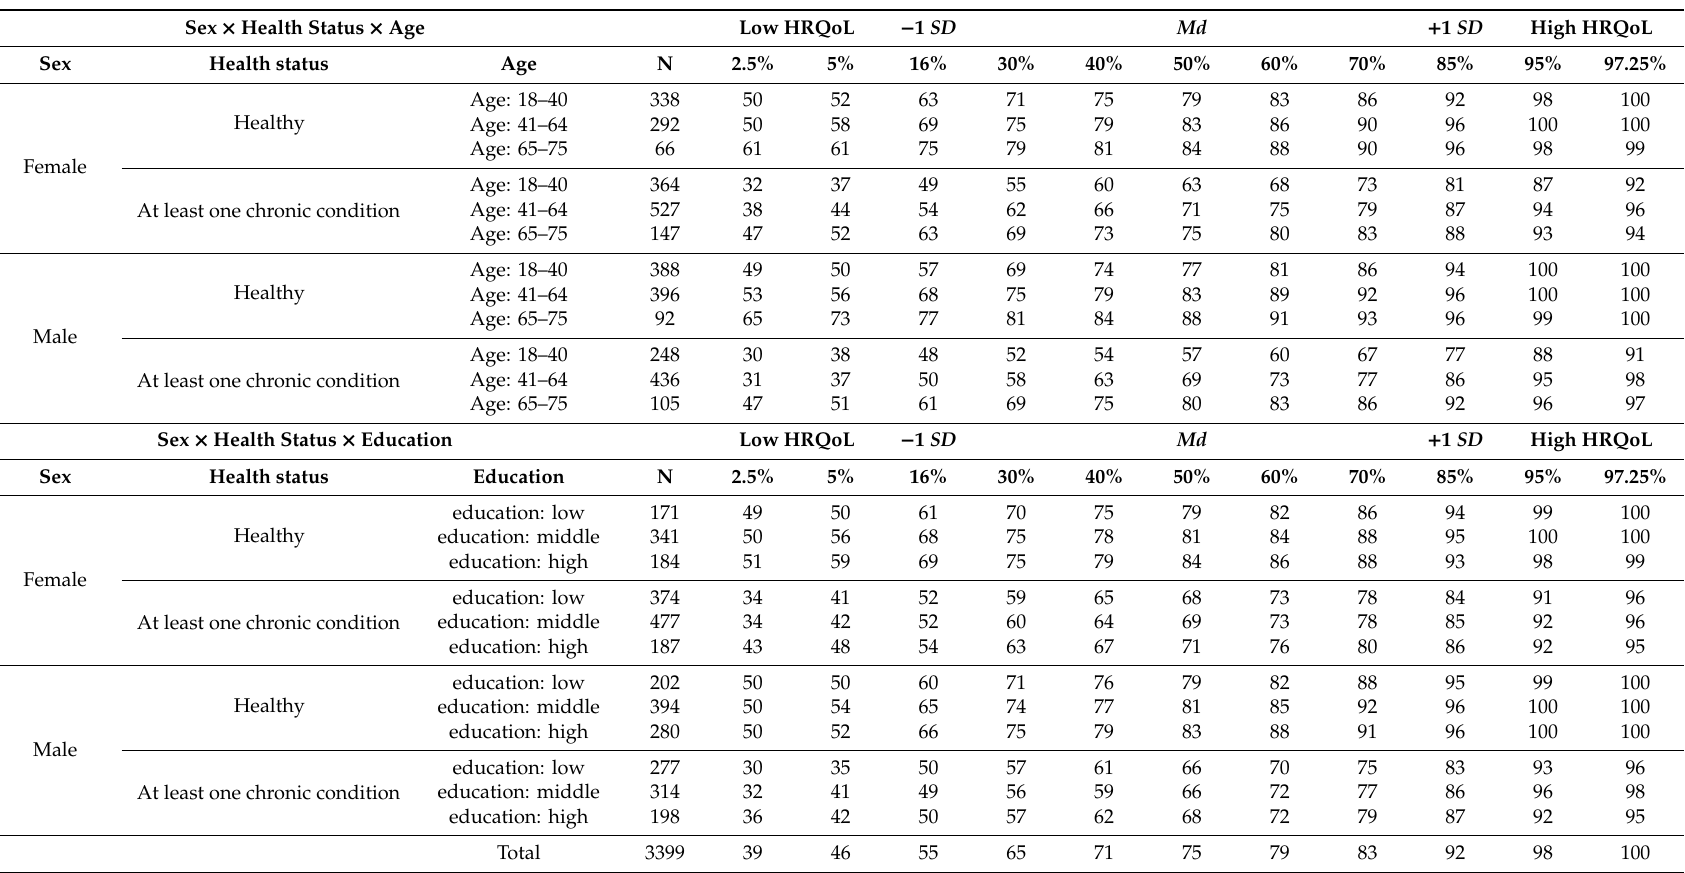
Table 4. Reference values for the QOLIBRI total score obtained from the general population NL sample stratified by sex, health status, age, and